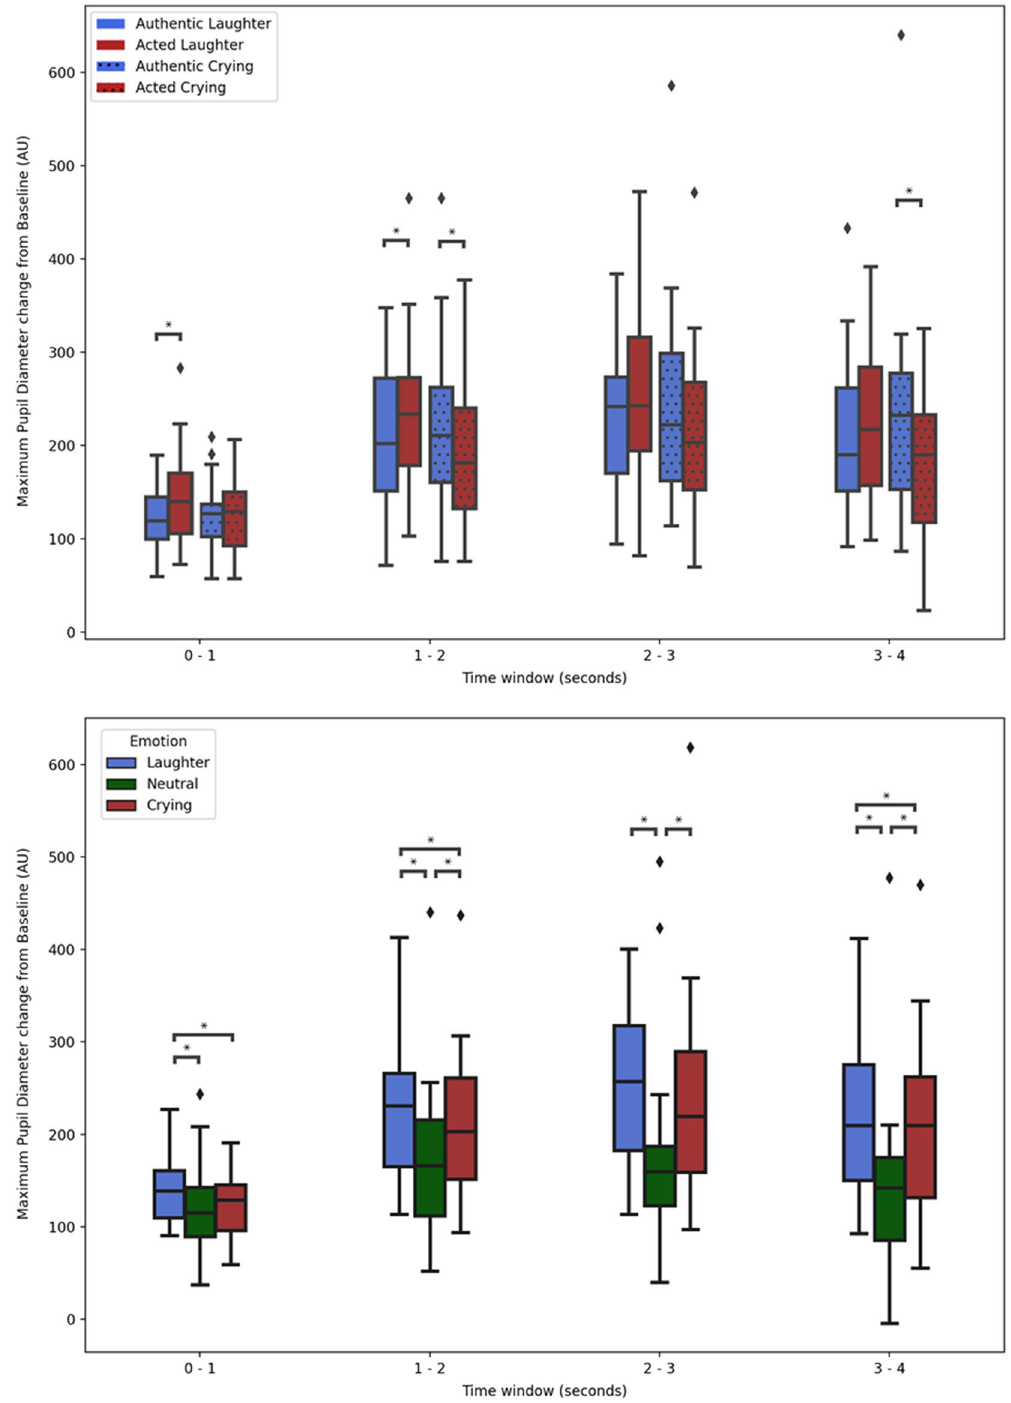
Figure 2. Box plots of maximum pupil diameter as a function of authenticity per emotion, showcasing the authenticity by emotion interaction (above), and of maximum pupil dilation as a function of emotion showcasing the main effect of emotion (below)—both for each time window (seconds). Statistically significant ( p < .05, after FDR correction) pairwise comparisons are highlighted with an *. Error bars represent ± 1.5 SD; AU = arbitrary